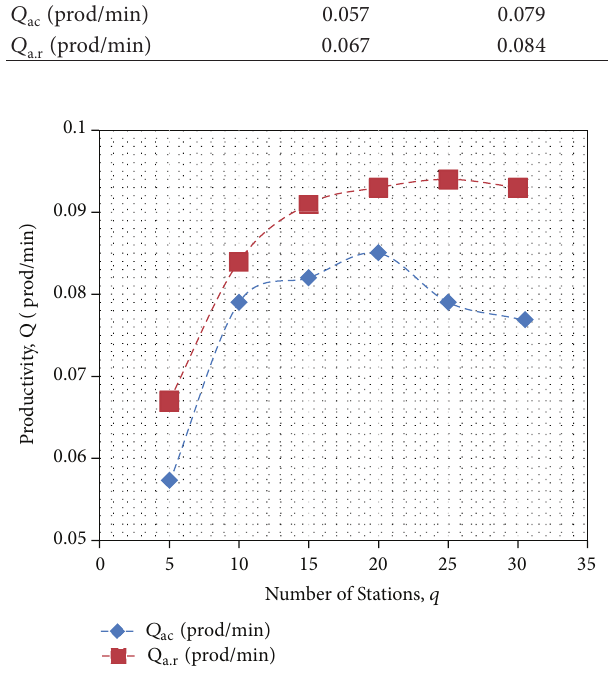
) with average reliability ac